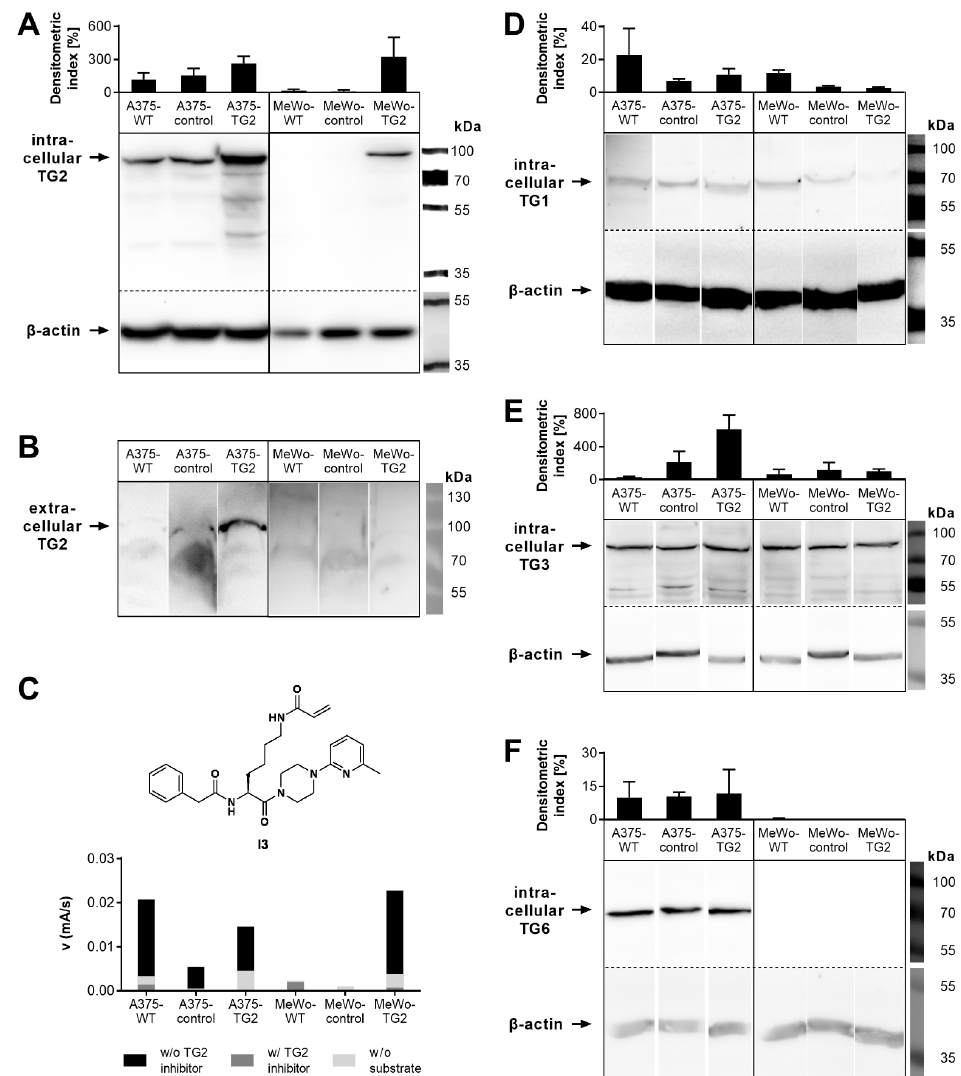
Figure 1. Biosynthesis of transglutaminases (TG) as well as secretion and cellular in vitro activity of TG2 in melanoma sub-cell lines. ( A , B ) TG2 biosynthesis ( A ) and secretion ( B ) were determined via Western blot using cell lysates and cell culture supernatants, respectively, and TG2 biosynthesis was analyzed using semi-quantitative densitometry. Densitometric indices were gained by normalization to respective ß-actin biosynthesis values. ( C ) Overall TG activity (black bars), remaining activity after selective inhibition using TG2 inhibitor I3 (dark grey bars, structure is shown above [47]), and baseline activity without substrate (light grey bars) as measured in vitro by fluorescence anisotropy assay in cell lysates. Data for A375-WT and MeWo-WT were published previously [43]. ( D – F ) Biosynthesis of TG1 ( D ), TG3 ( E ) and TG6 ( F ) was determined via Western blot and semi-quantitative densitometric analysis. Densitometric indices were gained by normalization to respective ß-actin biosynthesis values. Representative blots as well as mean values ± SD from individual experiments ( n ≥ 3, except from in vitro activity measurements ( n = 2, no SD applicable)) are